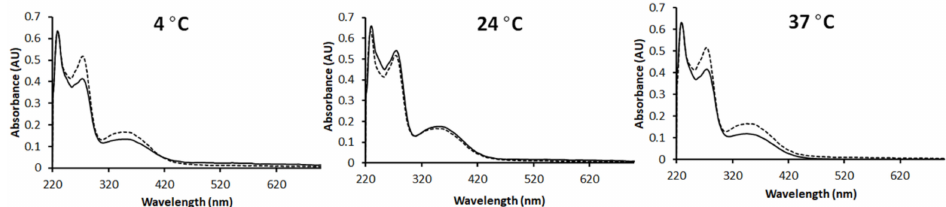
Figure 9. Left, Middle, and Right are the results of the stability tests of Flavopiridol in ILDF inhalable particles stored for up to 4 weeks at 4, 24, and 37 ◦ C, respectively. The UV-Vis spectra of the ILDF microparticles in 70% ethanol (solid black line) after 4 weeks of storage is displayed with that of the freshly produced ILDF microparticles (dashed black line). The absorption intensity was normalized using λ = 230 nm to allow for easy display and comparison.